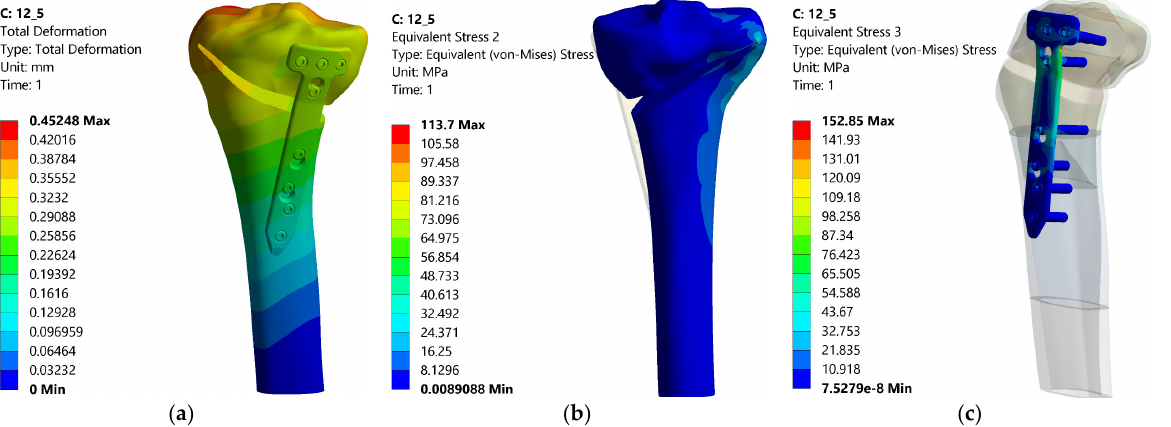
Figure 13. Distributions of the total deformation, equivalent stress in tibia and equivalent stress in the plate—0%.